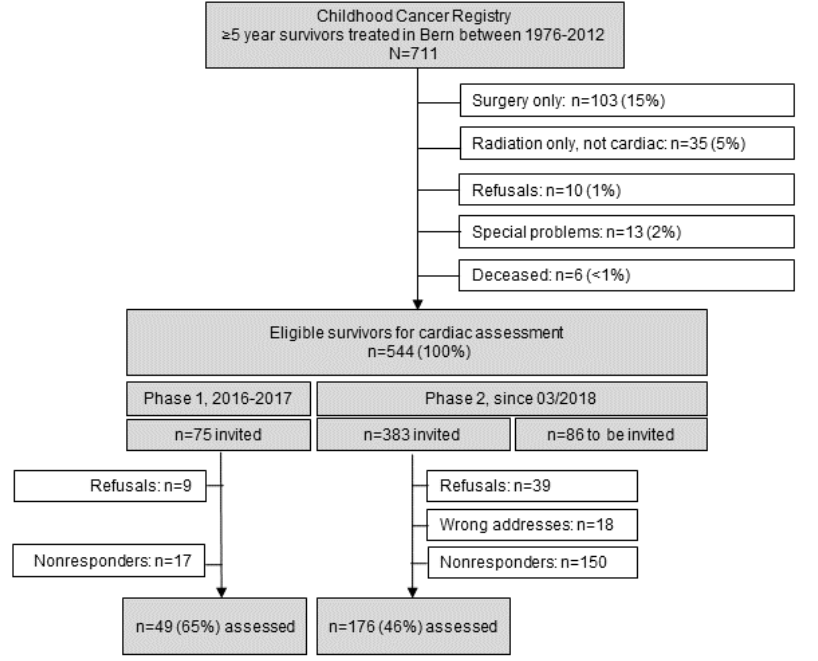
Figure 3. Recruitment of childhood cancer survivors eligible for the study, current as of October 1,